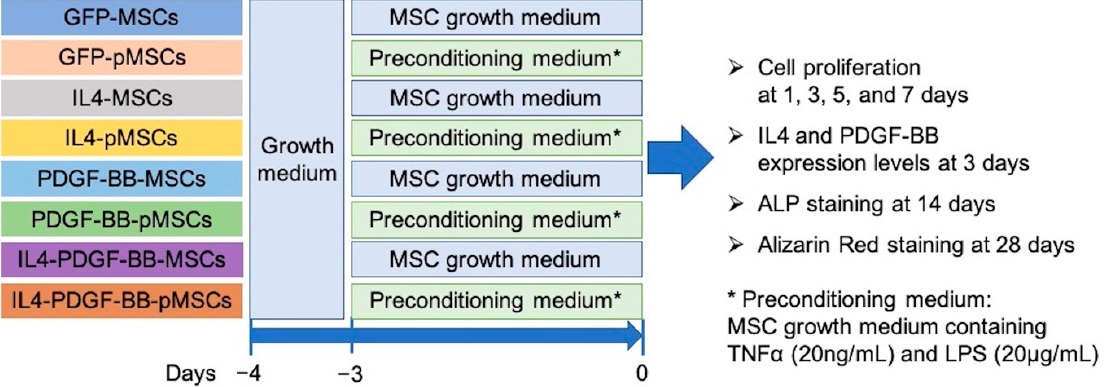
Figure 2. The experimental outline of in vitro experiments. GFP-MSCs, IL4-MSCs, PDGF-BB-MSCs, or IL4-PDGF-BB-MSCs were seeded into T75 flasks and cultured in an MSC growth medium for 1 day. For the non-preconditioning MSC groups, the cells were cultured for 3 days with a fresh MSC growth medium. For the preconditioning MSC groups, cells were cultured in the MSC preconditioning medium for 3 days. The cells from all eight groups were washed three times with Dulbecco’s phosphate-buffered saline. The cells were trypsinized and seeded for each experiment, including cell proliferation, IL4 and PDGF-BB expression level, and osteogenic differentiation performed by alkaline phosphatase (ALP) staining and Alizarin red-staining. Abbreviations: MSCs, mesenchymal stromal cells; pMSCs, preconditioning MSCs; TNF α , tumor necrosis factor-alpha; LPS, lipopolysaccharide.